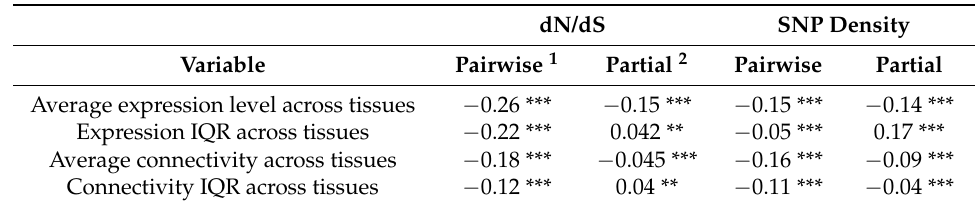
Table 1. Spearman’s rank correlation coefficient between gene expression-related measures and sequence evolution.